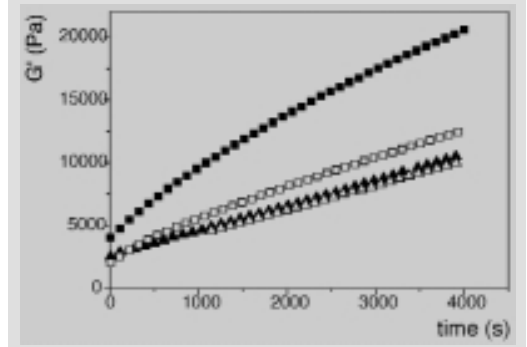
Figure 13: Storage modulus at 0.1 rad/s versus reaction time at 180°C for MAH1/GMA1 50/50 ( Û , Ú ) and MAH2/GMA1 50/50 ( · , ‚ ) blends after 40 min ( Û , · ) and 5 h ( Ú , ‚ ) diffusion at 105°C (preshear: g R = 5000).